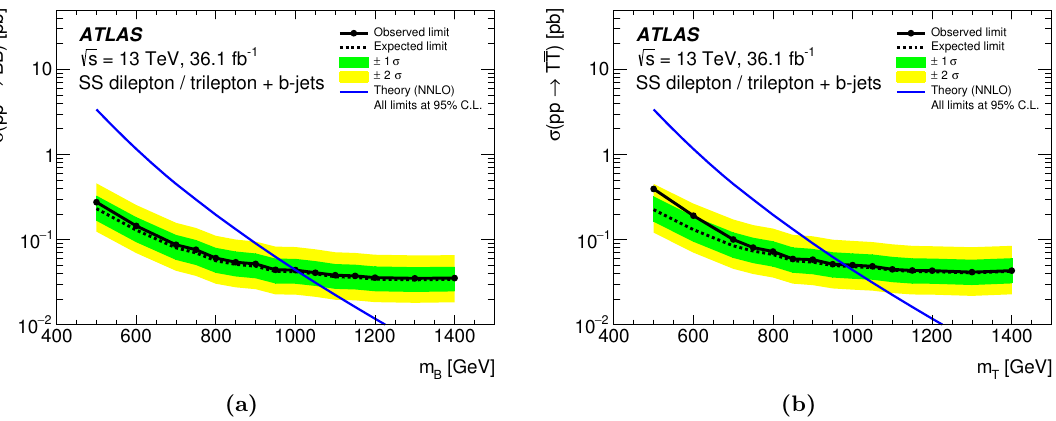
Figure 8 . Expected and observed limits on (a) vector-like B - and (b) T -quark pair production as a function of mass, assuming the branching ratios expected in the singlet model. The expected 95% CL limits are shown as a dashed line with its NNLO theory prediction is shown as a continuous